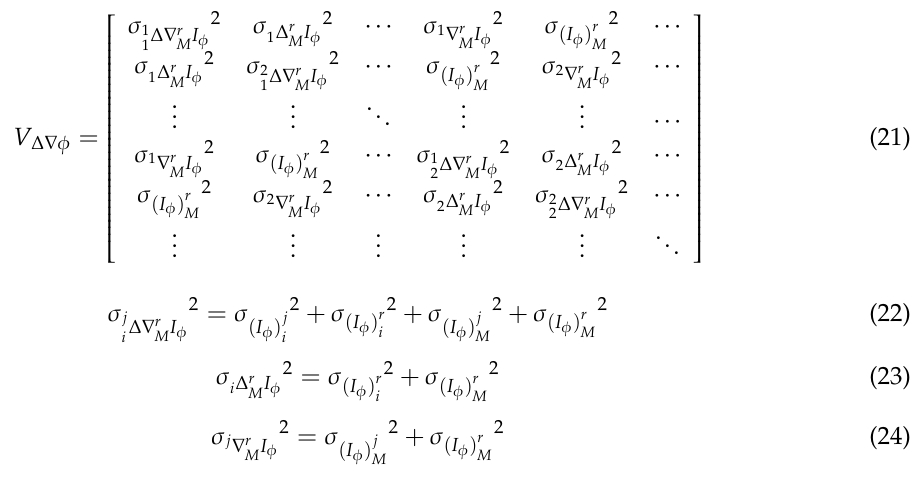
Figure 3. One sigma of code noise and multipath (CNMP) against the smoothing time. The elements of the covariance matrix of the double-di ff erence measurement are expressed in Equations (21)–(24). Because the double-di ff erence measurements were made with one master station, all measurements were related with the reference satellite of the master station. In addition, there are many correlations based on the terms shared by the